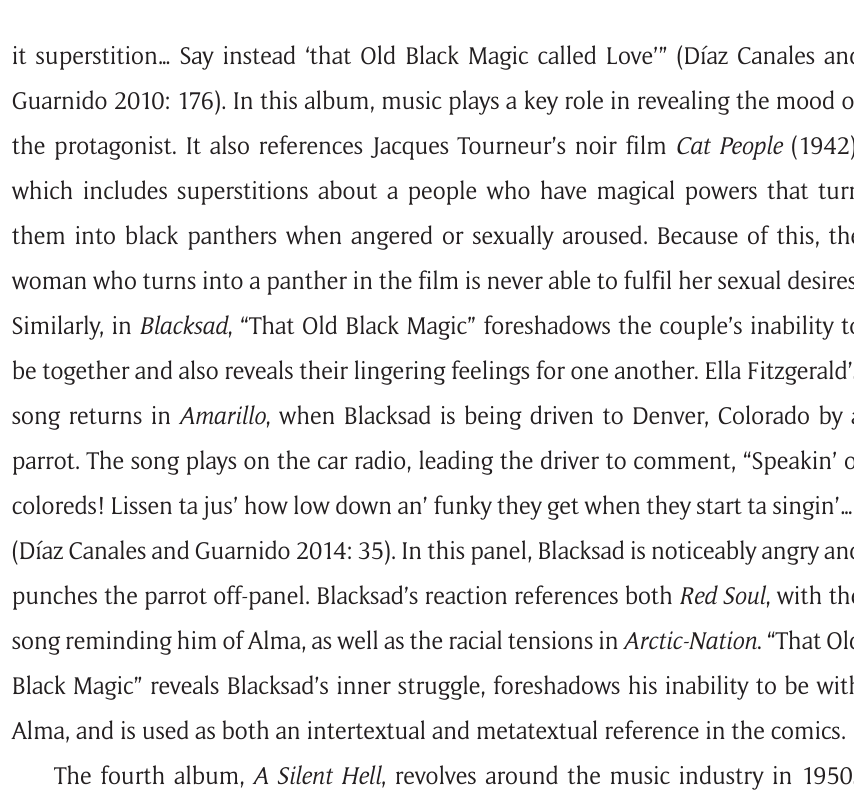
Figure 3: Juan Díaz Canales and Juanjo Guarnido, Blacksad , 2010, Dark Horse Comics, p.